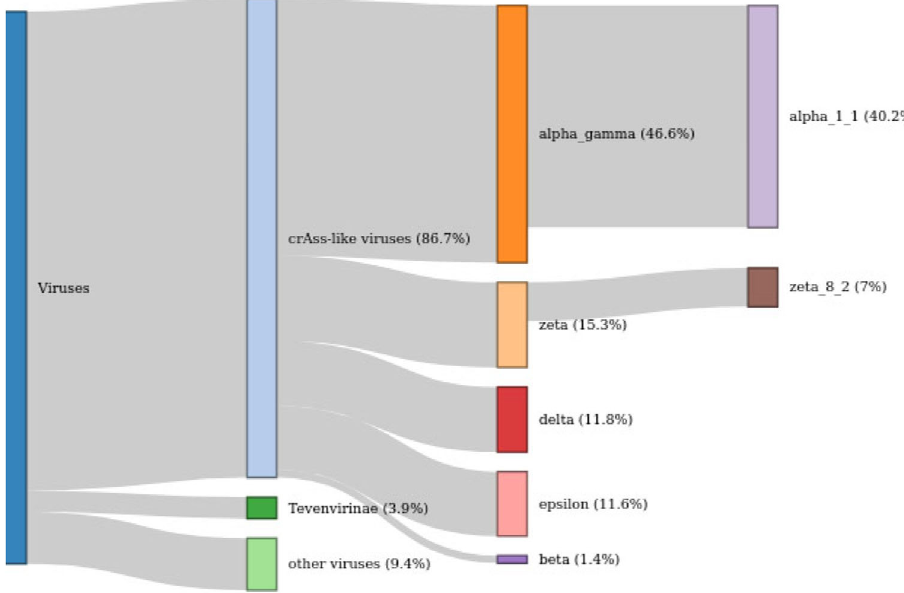
Fig. 5 The crAss-like phages dominate the human gut virome. The schematic shows the fractions of sequence reads mapped to different groups of virus genomes. The total represents 49,540,005 reads mapped to virus